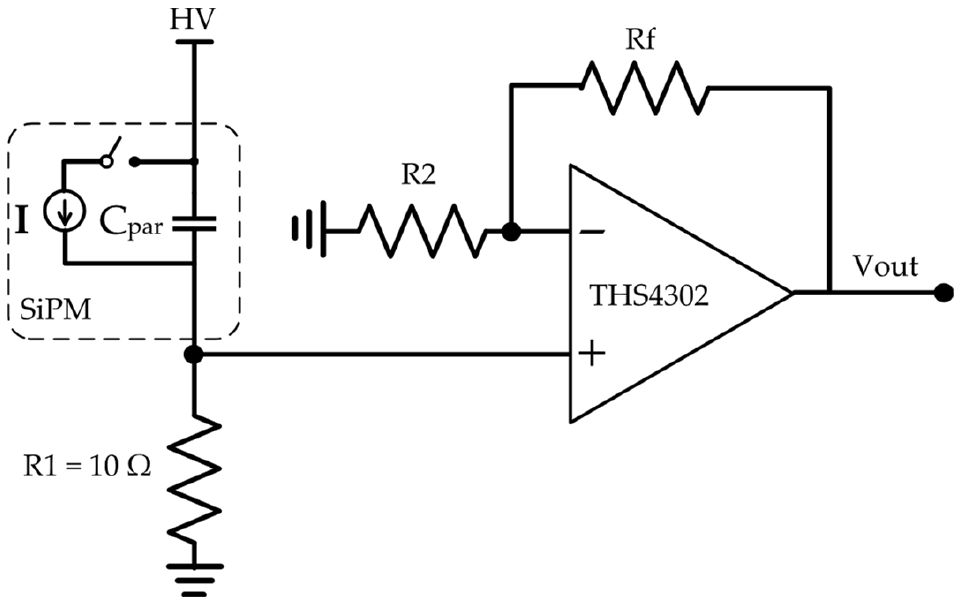
Figure 7. Conventional OA-based VA as readout circuitry for SiPM